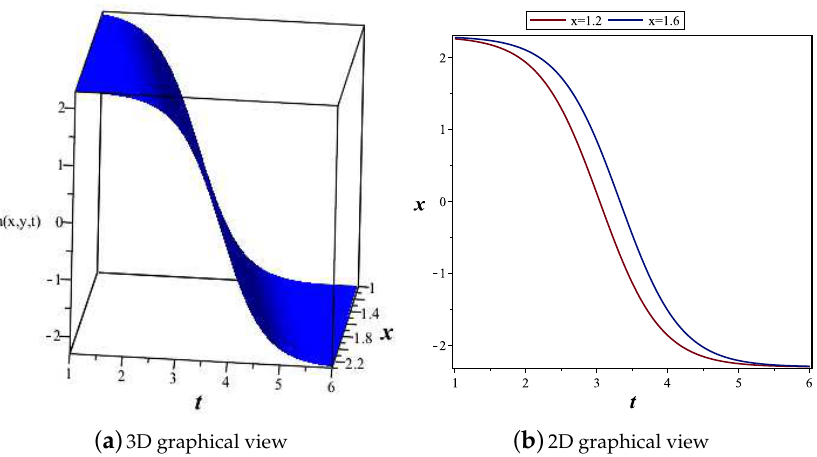
Figure 8. Graphical representation of Equation (57) within interval 1 ≤ x ≤ 2.3 and 1 ≤ t ≤ 6 (( a ) 3D plot, ( b ) 2D plot for x = 1.2,